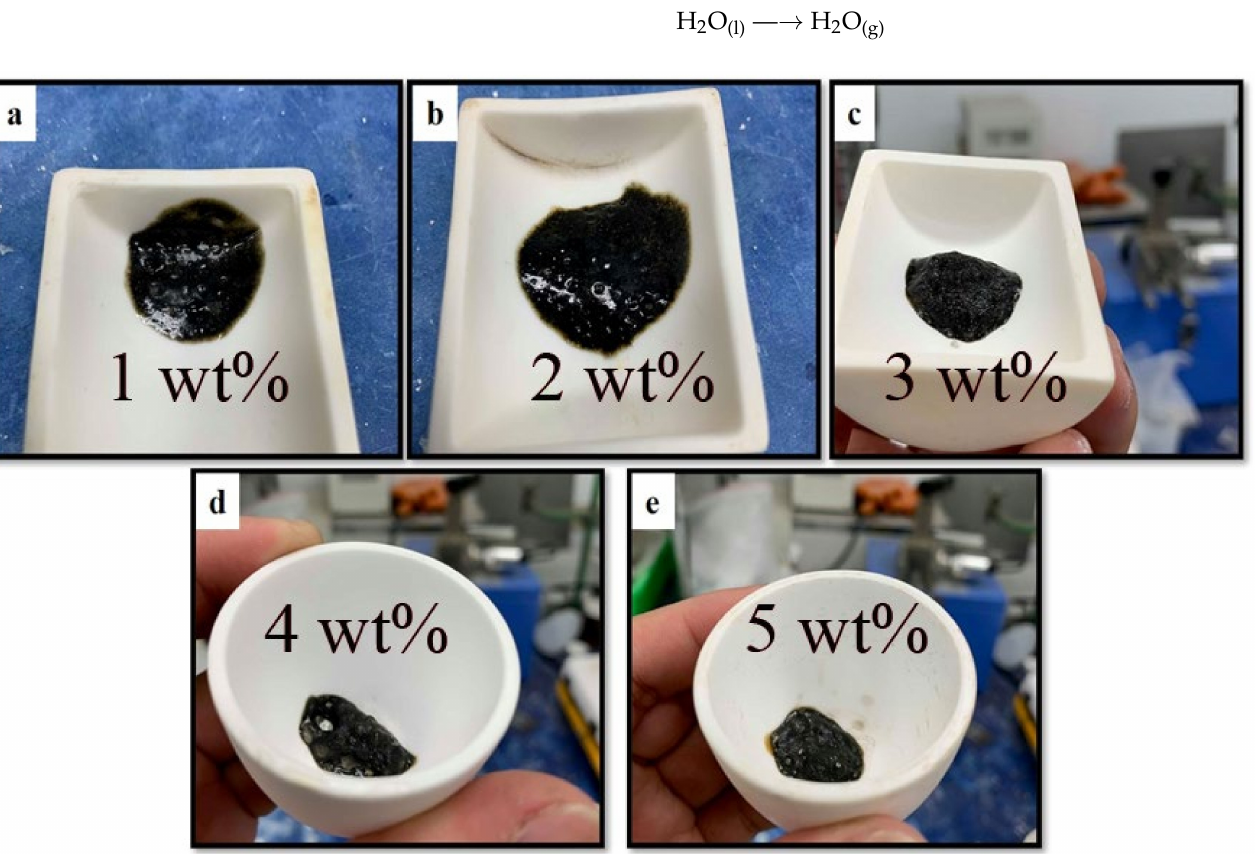
Figure 3. Photographs of sodium silicate-based intumescent flame-resistance coatings with different contents of ( a ) 1, ( b ) 2, ( c ) 3, ( d ) 4 and ( e ) 5 wt.% of ammonium polyphosphate and pentaerythritol after exposure to 1000 ◦ C heating for an hour,